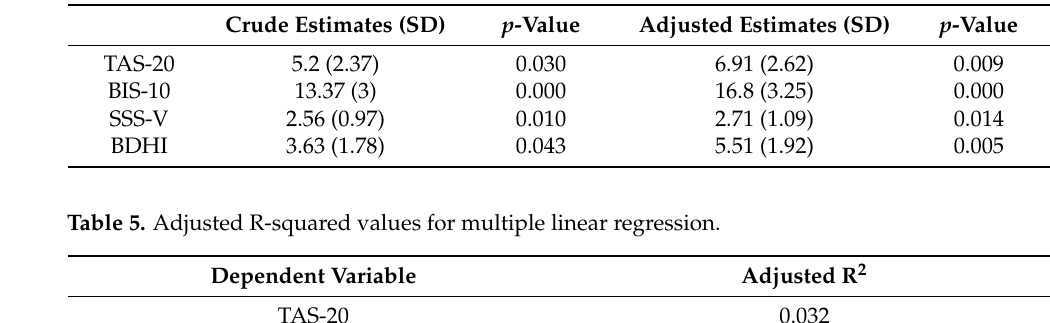
Table 4. Results of multivariate linear regression model analysis, adjusted for age and gender.